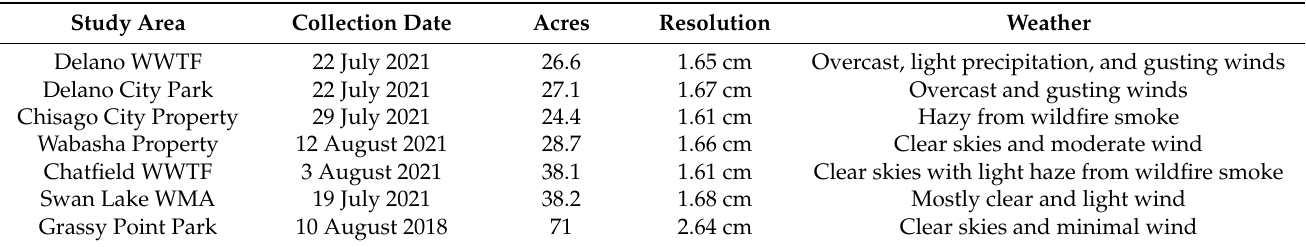
Table 1. UAS collections at each study area. All imagery in 2021 was acquired at 121 m above ground level with 85% endlap and 70% sidelap. Grassy Point Park was collected in 2018 with 85% endlap and 65%